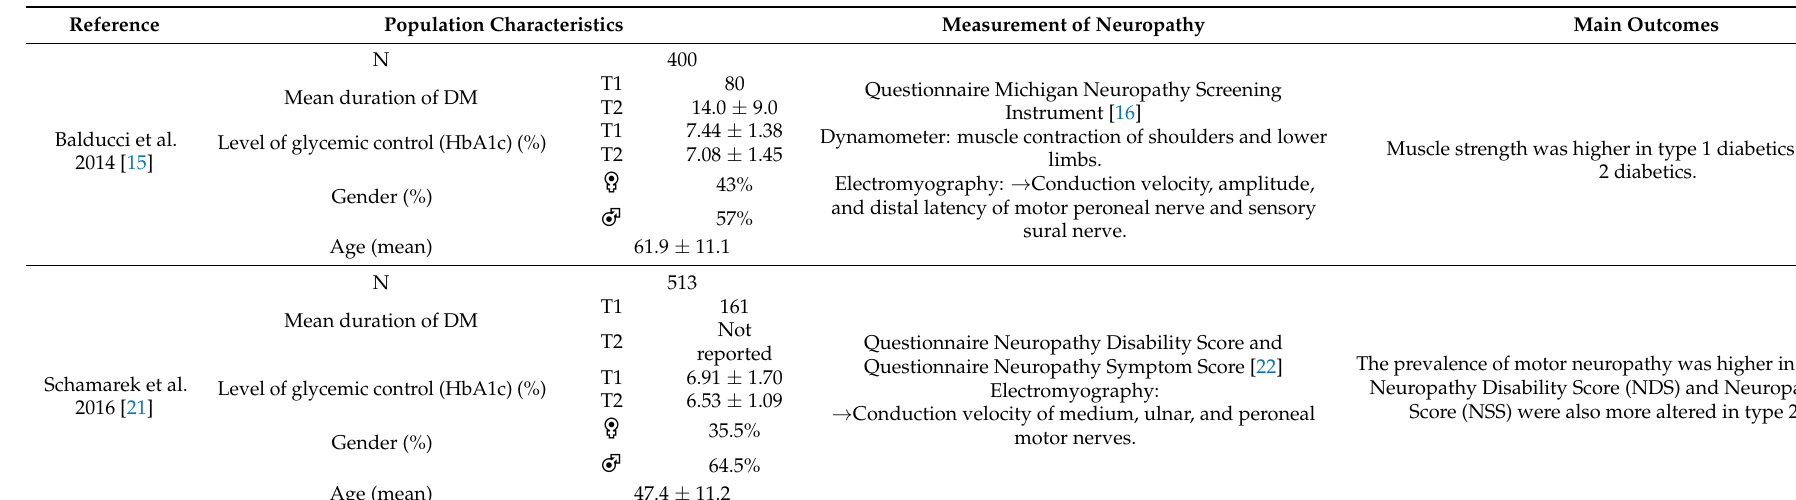
Figure 1. Systematic review workflow.